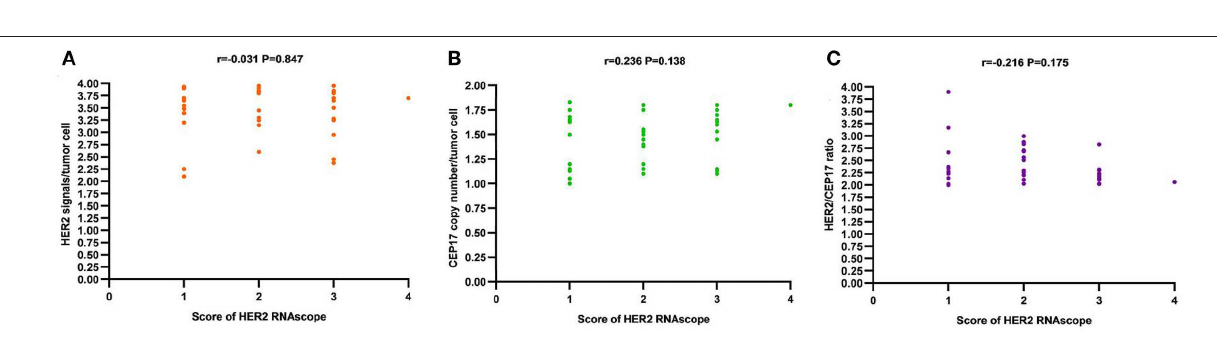
FIGURE 6 | The correlation of HER2 mRNA expression by RNAscope (score 1 to 4) and HER2 FISH features [average HER2 signals/tumor cell (A) , average CEP17 copy number/tumor cell (B) , and HER2/CEP17 ratio (C) ].